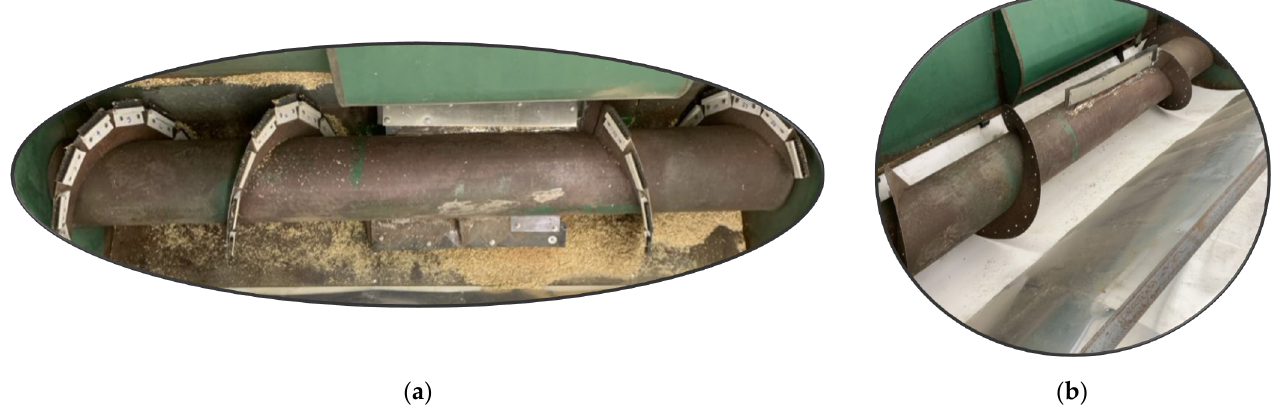
Figure 4. Auger redesign implementation: ( a ) brush concept and ( b ) shim concept.